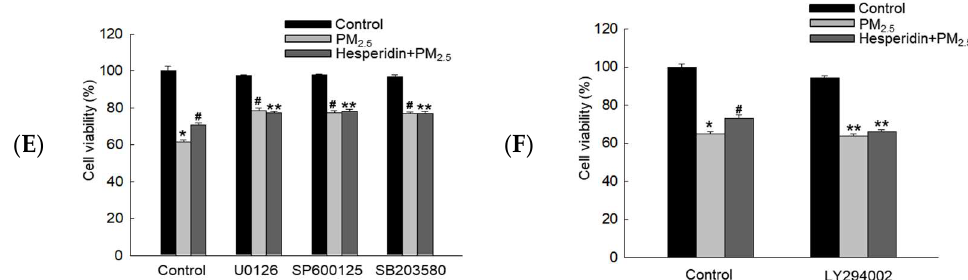
Figure 4. Hesperidin mitigated PM 2.5 -induced cell apoptosis and MAPK activation. Cells were pretreated with hesperidin (50 µ M) for 1 h, and then exposed to PM 2.5 (50 µ g/mL) for another 24 h. ( A ) Cell lysates were subjected to western blotting for Bax, Bcl-2, cleaved caspase-9, cleaved caspase-3, ( B ) phospho-ERK, ERK, phospho-JNK, JNK, phospho-p38, p38, phospho-Akt, Akt. Actin was used as the loading control. Cells were pretreated with hesperidin (50 µM), U0126 (50 nM), SP600125 (5 µM), SB203580 (10 µM), and LY294002 (50 µM) for 1 h, and then exposed to PM 2.5 (50 µg/mL) for 24 h. ( C ) Hoechst 33342 staining was used to assess cellular apoptosis, and the arrows indicate apoptotic bodies. Cell viability was assessed using ( D ) trypan blue, arrows indicating the dead cells, and ( E , F ) MTT assays. * p < 0.05, # p < 0.05, and ** p < 0.05 compared with the control cells, PM 2.5 -exposed cells, and hesperidin + PM 2.5 -exposed cells, respectively.